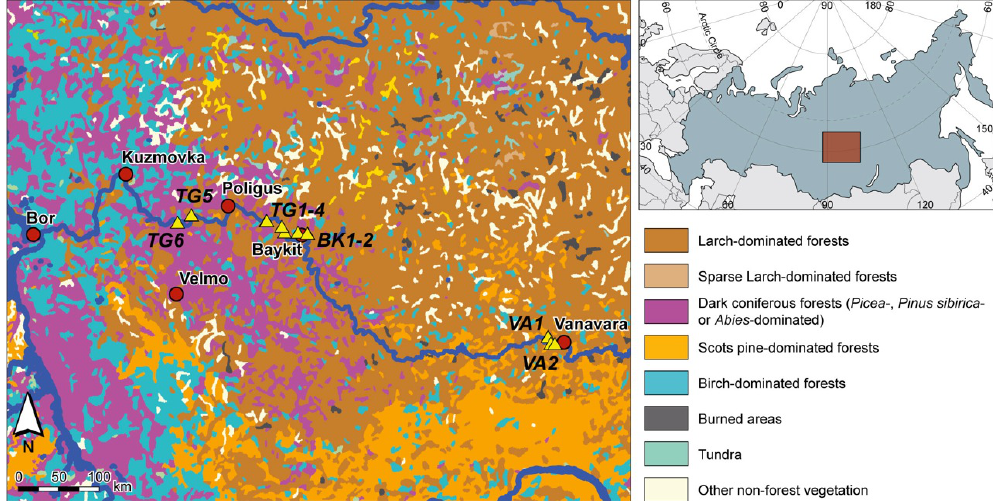
Fig. 1. Vegetation map (Isaev, 1990) and study sites at 60 ◦ N and east of 90 ◦ E as determined from satellite images (see site; chapter site selection). The main settlements are Bor, Kuzmovka, Velmo, Poligus, Baykit and Vanavara. The latter 4 settlements also served meteorological stations (see Table 1). The study sites are indicated as VA (Vanavara), BK (Baikit) and TG